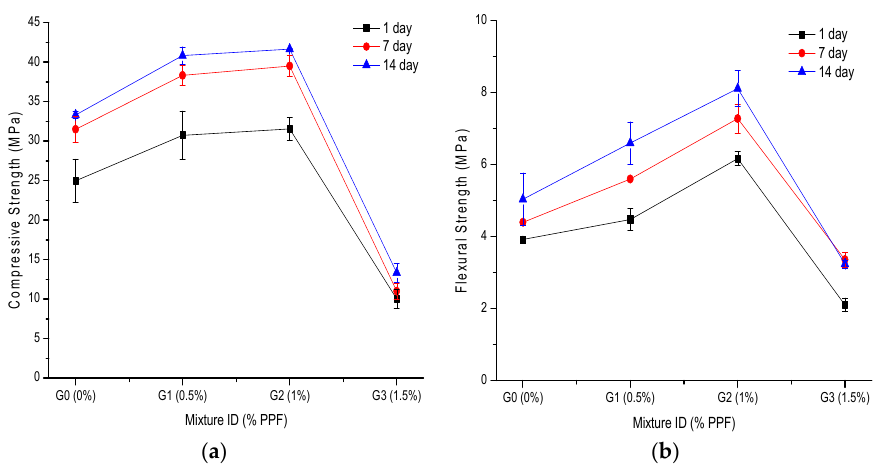
Figure 3. Effect of PPF content at different curing times on ( a ) compressive strength; and ( b ) flexural strength .